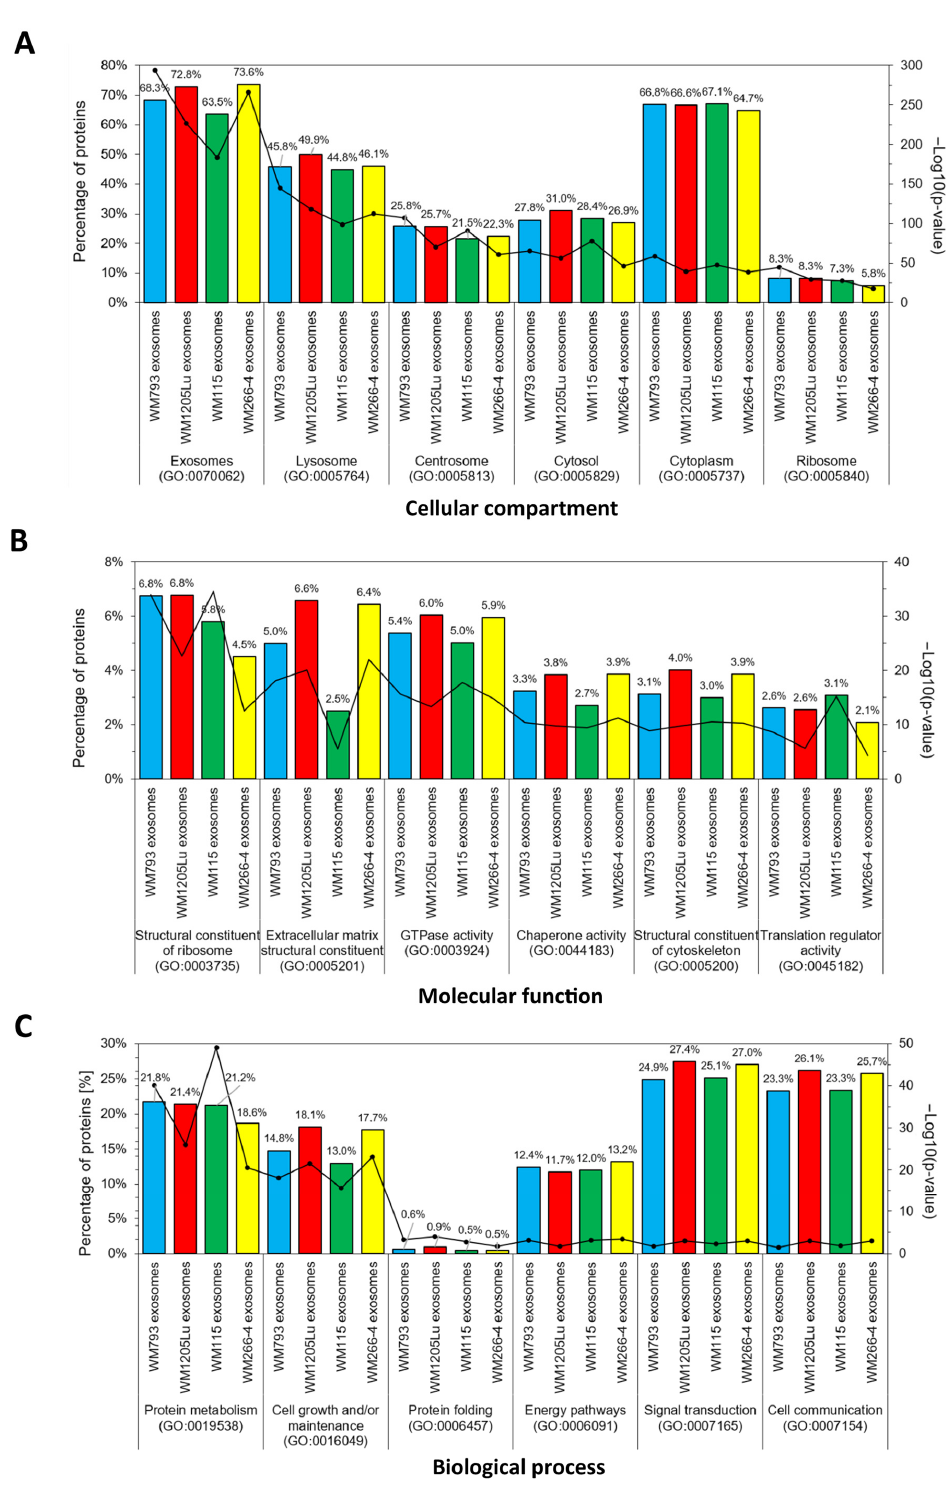
Figure 7. GO analysis regarding “Cellular compartment” ( A ), “Molecular function” ( B ), and “Bi- ological process” ( C ) of proteins identified in CM-derived exosomes. FunRich 3.1.3. software with the UniProt (release 2022_11) database was used, and six categories with the highest statis- tical significance of protein enrichment ( p < 0.001) were presented in graphs. Complete results are presented in Supplementary Data S2. WM115/WM266-4,WM793/WM1205Lu—isogenic pairs (primary/metastatic) of CM cell lines that were used for exosome